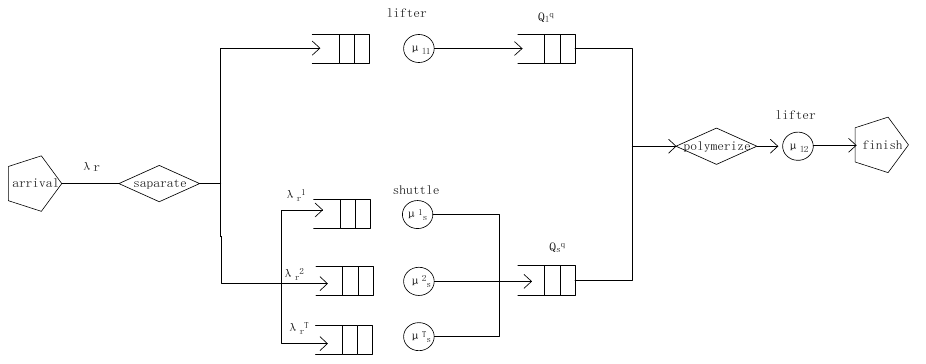
Figure 3. Separation-aggregation queuing network model.